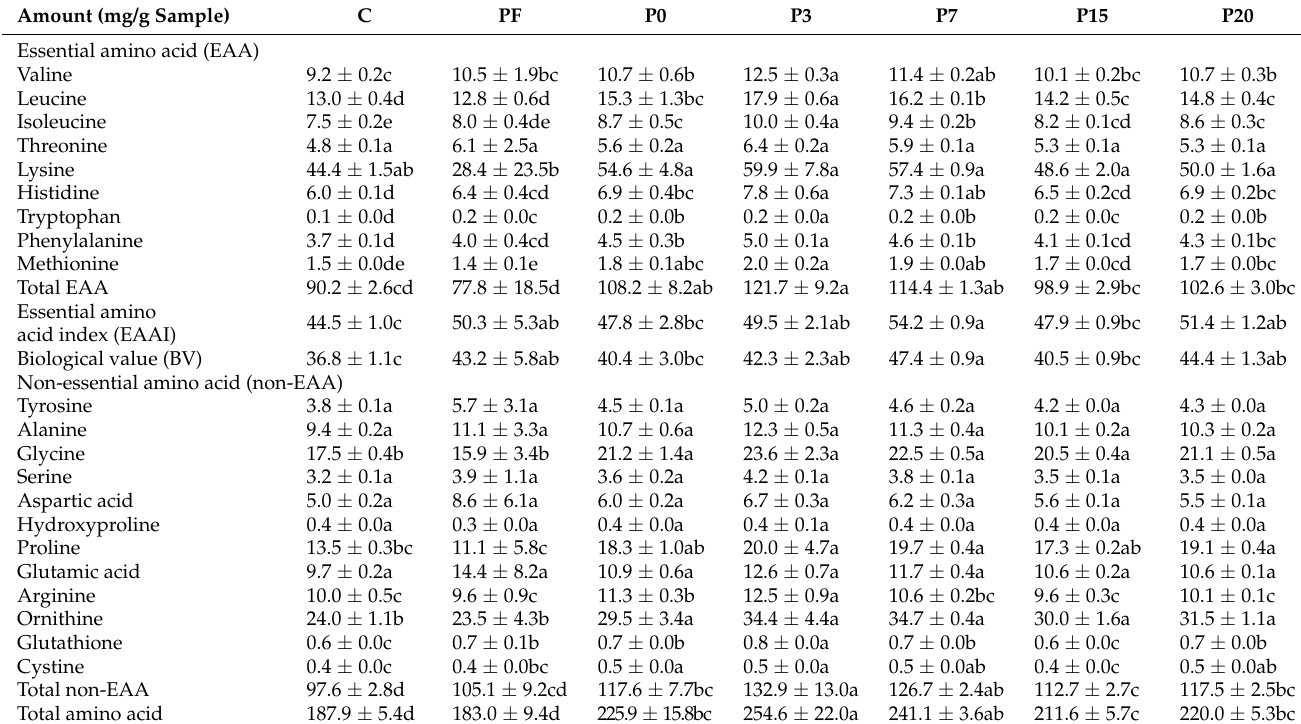
Values are given as mean ± standard deviation from triplicate determinations. Different letters in the same row indicate significant differences ( p < 0.05). Diet nomenclature: C: control, PF: diet supplemented with pig feed, P0–P20: diets contained 0–20% perilla seed,